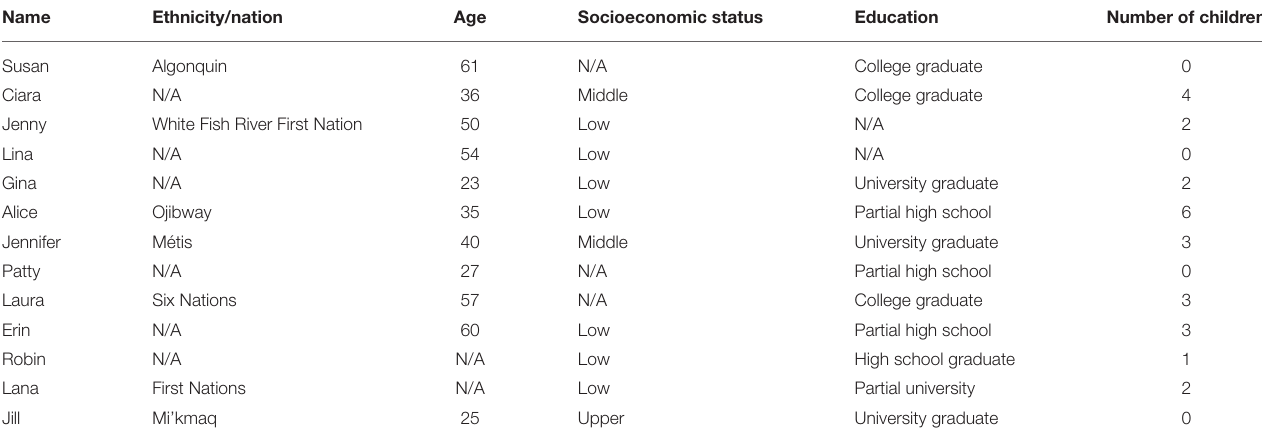
TABLE 1 | Participants